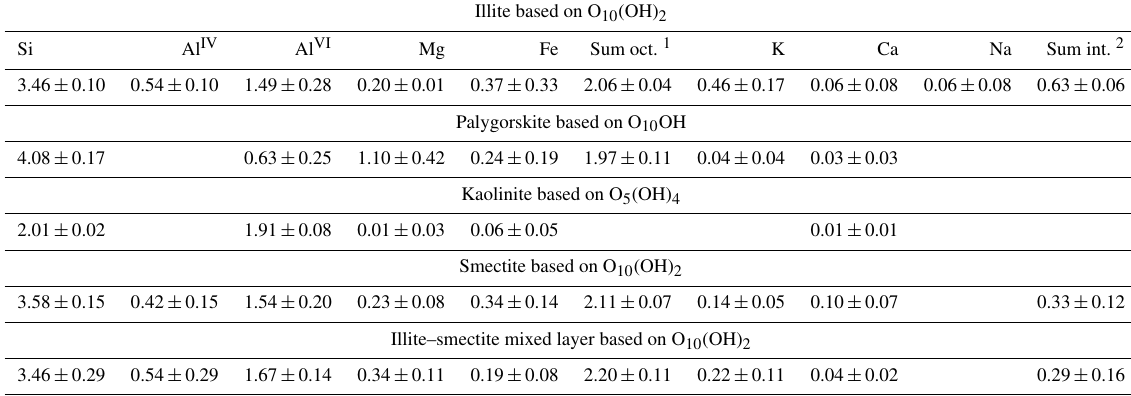
Illite based on O 10 (OH) 2